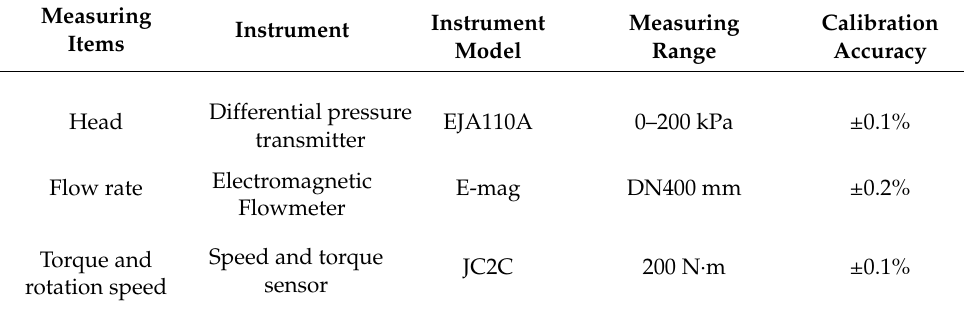
Table 2. Main equipment of test measurement